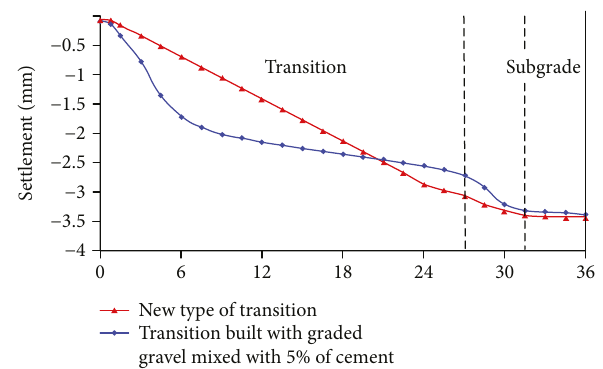
Figure 14: Diagrams for longitudinal distribution of the volume of vertical settlement on rail surface.